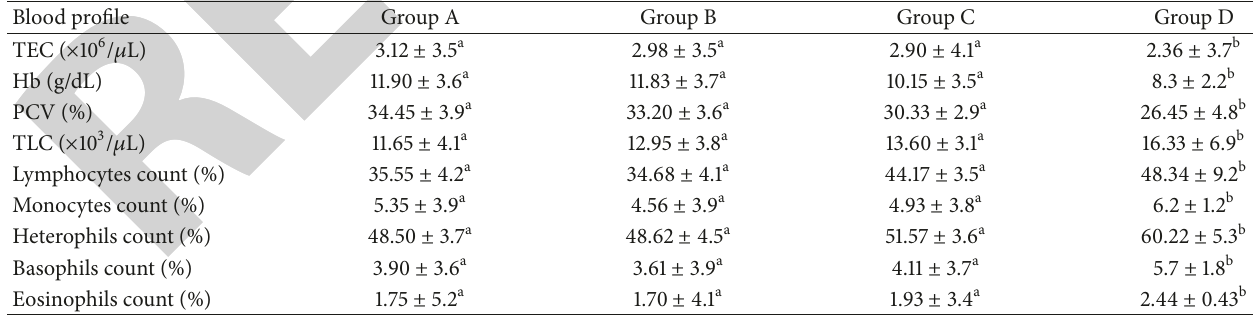
Basophils count (%) Eosinophils count